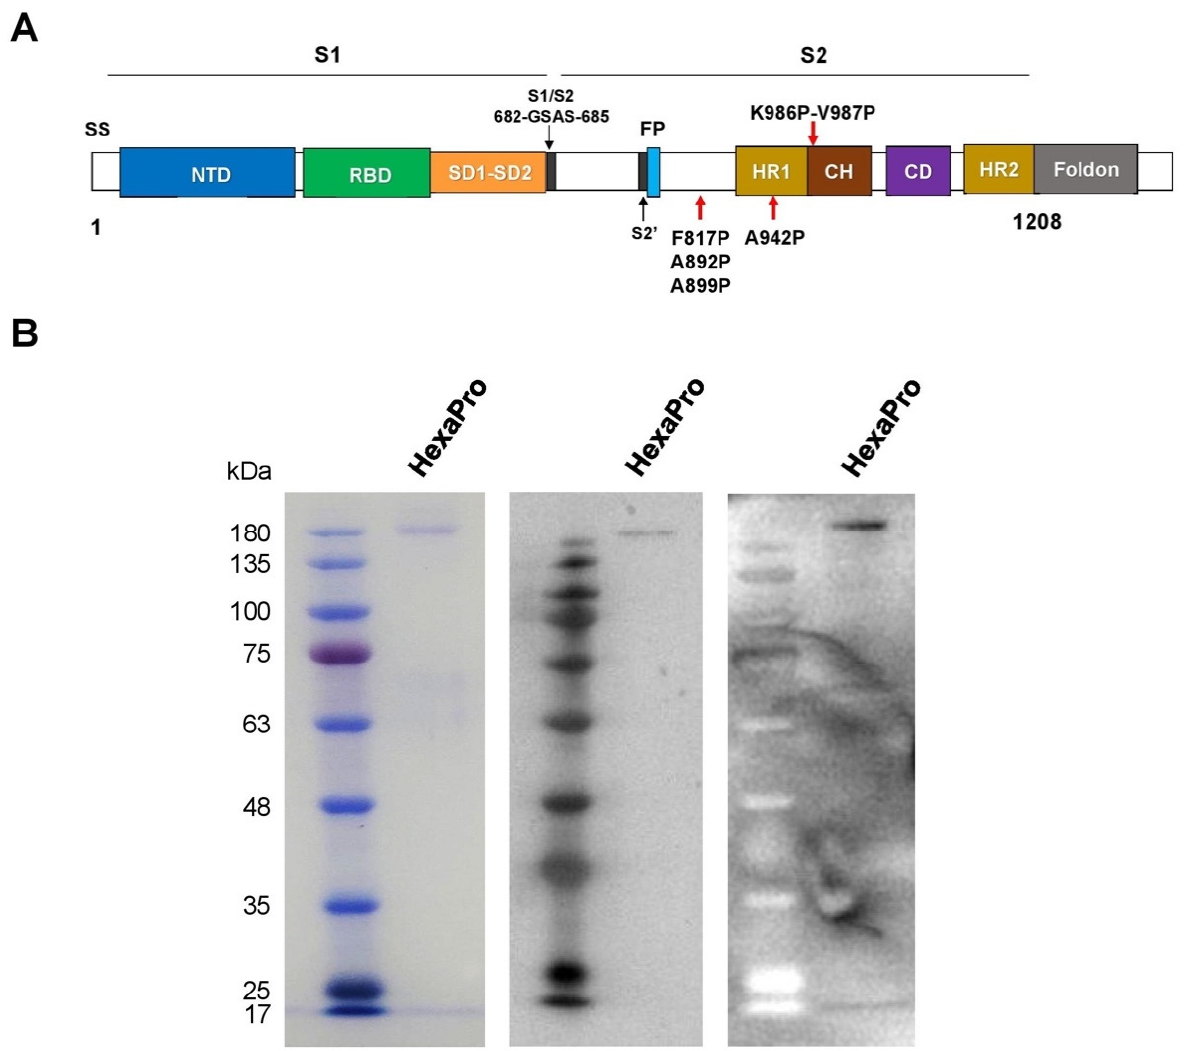
Figure 1. The recombinant SARS-CoV-2 HexaPro spike protein. ( A ) Schematic representation of the prefusion-stabilized SARS-CoV-2 HexaPro ectodomain showing the S1 and S2 subunits. Four additional proline substitutions from the S-2P construct are indicated by the red arrows shown below the construct. ( B ) The HexaPro protein expressed in HEK293T cells was purified and characterized by SDS-PAGE ( left ), Western blot using a commercial anti-RBD ( middle ), and Western blot using pooled convalescence sera ( right ).